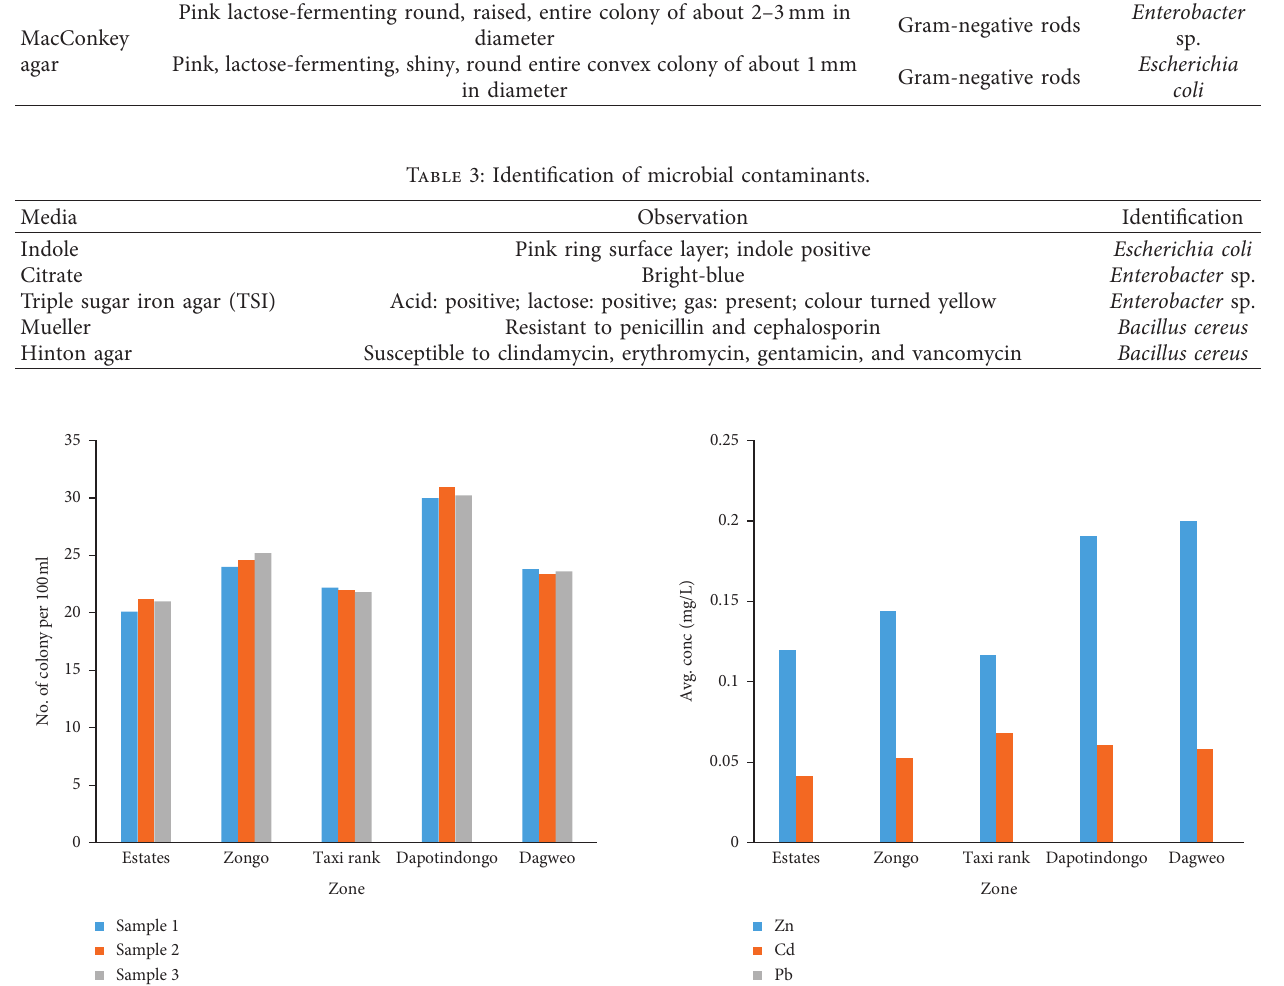
Figure 3: Number of colonies per 100mL sample compared among zones and individual samples.